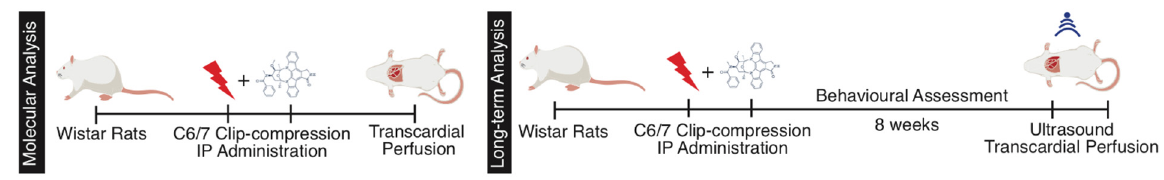
Figure 1. Schematic overview of experimental paradigms to assess the impact of acute intraperitoneal midostaurin administration after cervical SCI. In phase 1, the molecular impact of midostaurin at 24 h post-SCI was assessed using the multiplex Luminex assay and RT-qPCR. This phase consisted of four cohorts: C6/7 laminectomized sham ( n = 6), C6/7 SCI control ( n = 5), 0 mg/kg midostaurin ( n = 6), and 25 mg/kg midostaurin ( n = 6). In phase 2, the impact of midostaurin on functional recovery was assessed using four cohorts ( n = 5 per cohort): C6/7 laminectomized sham, SCI control, 0 mg/kg midostaurin, and 25 mg/kg midostaurin.